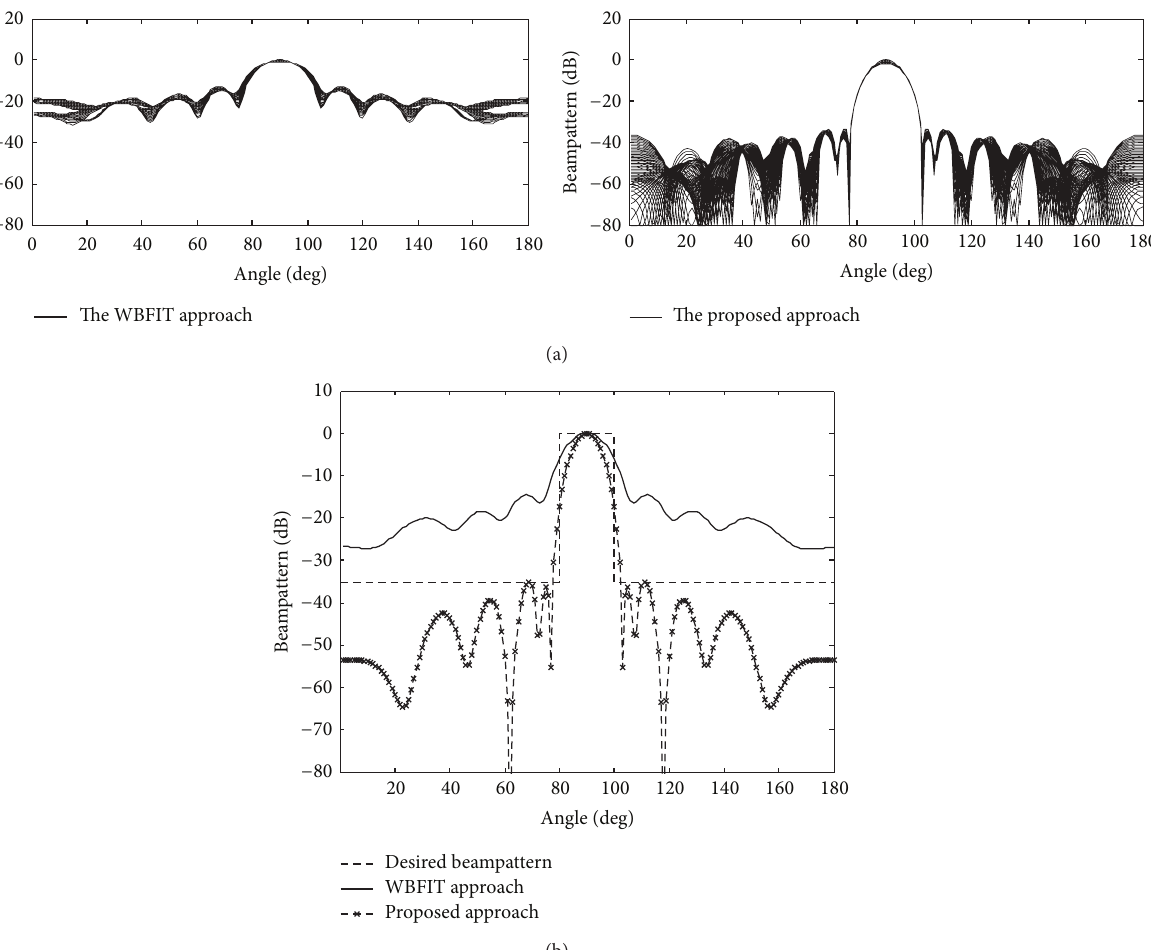
Figure 1: Comparison of the synthesized beampattern. The desired beampattern is given in (23). (a) Plot at all the 64 frequencies using the WBFIT approach and the proposed approach. (b) Plot at center